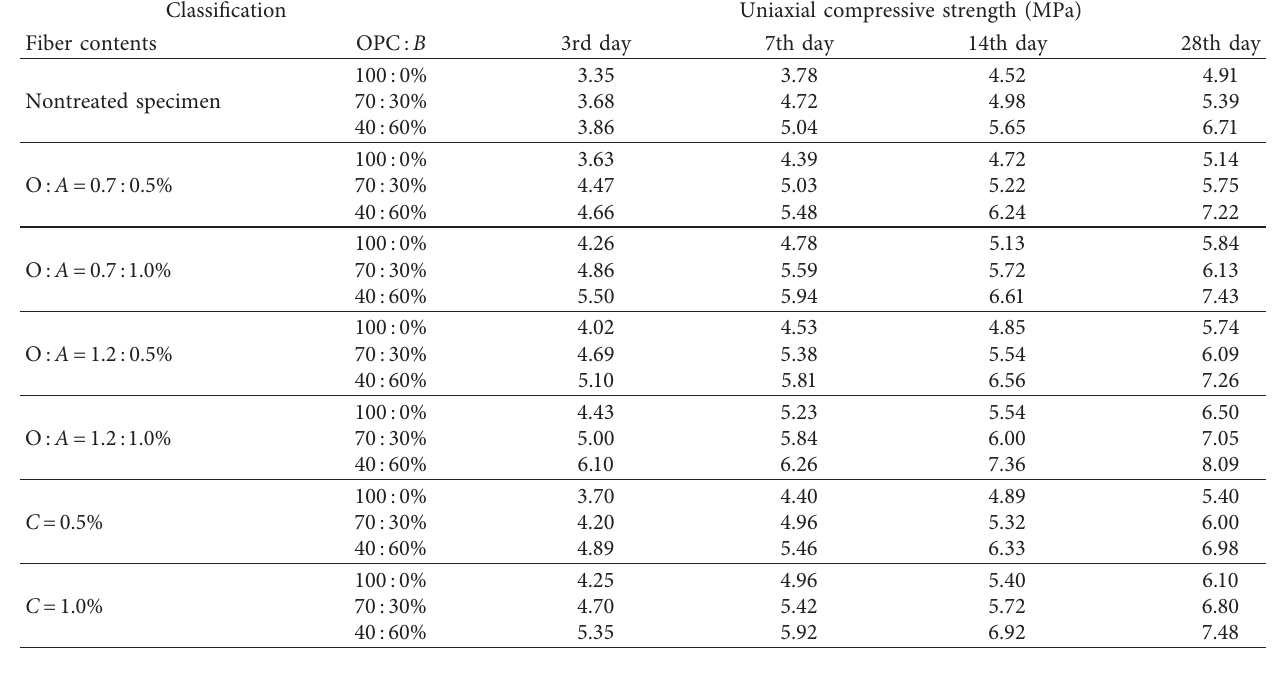
Table 4: Results of uniaxial compressive strength test of sand-gel.